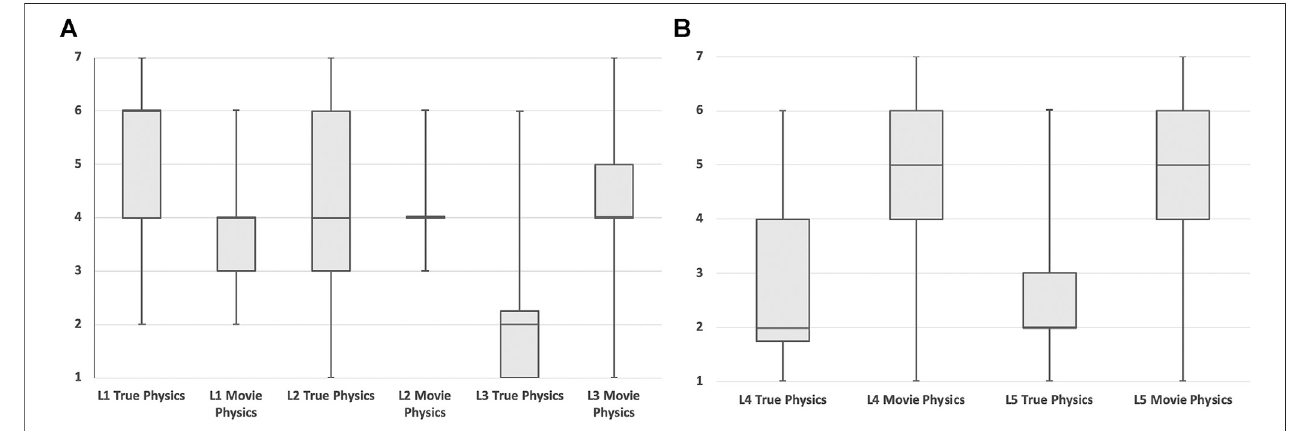
FIGURE 4 | Study 1 Likert responses L1-L3 (A) and L4-L5 (B) visualized as box plots, interquartile ranges and minimum and maximum responses. In (A) , responses closer to 4 are perceived as closer to realism, whereas in (B) responses closer to 7 are perceived as closer to realism (Pouke et al., 2020).